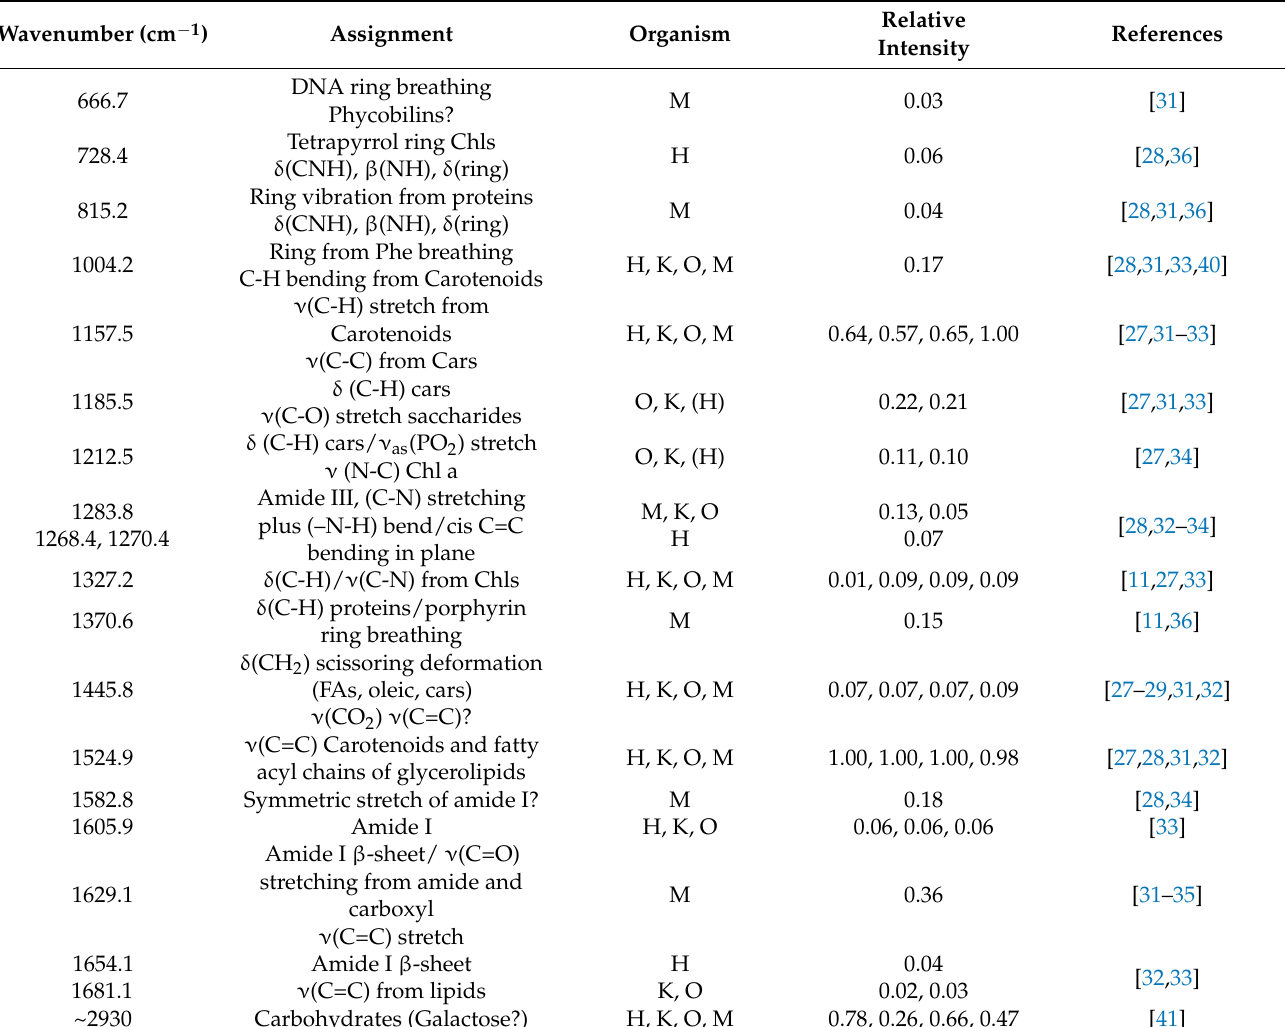
Table 4. Band assignments for Raman spectra of three algae and one cyanobacterium. M, Microcoleus vaginatus ; H, Haslea spicula ; K, Klebsormidium flaccidum ; O, Oocystis